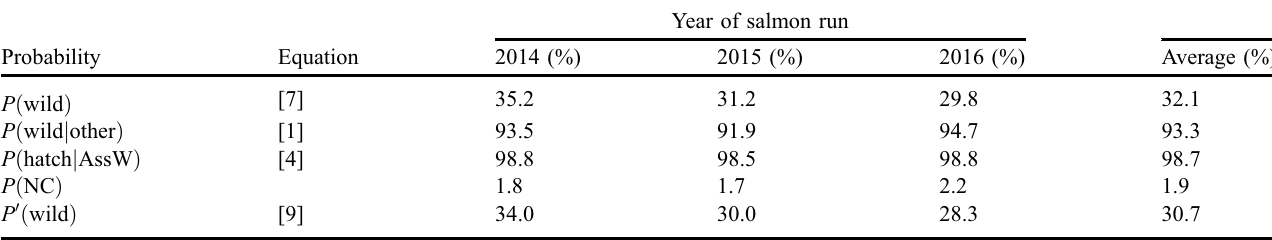
Table 5. Probabilities associated to the 2014 – 2016 salmon runs (real data) in the Garonne-Dordogne basin. Year of salmon run Probability Equation 2014 (%) 2015 (%) 2016 (%) Average (%) P wild ð [7] 35.2 32.1 [1]